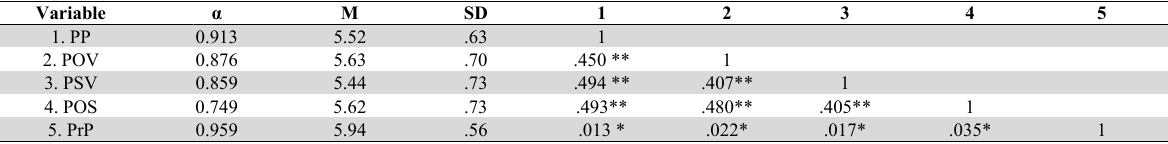
Descriptive statistics and bivariate correlations